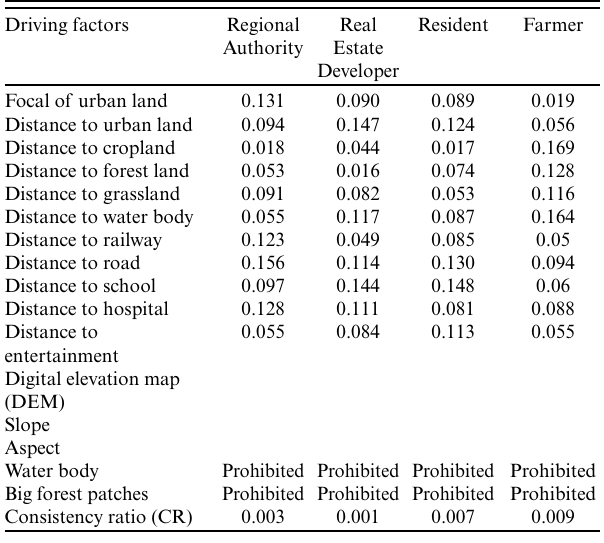
Table 7 . The standardized preferences of regional authority, real estate developer, resident, and farmer agents on the driving factors for the rapid development